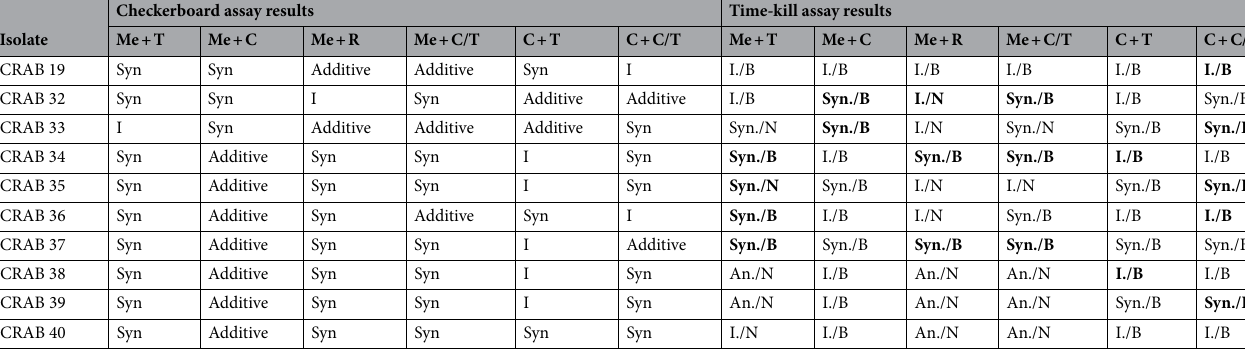
Table 6. Comparison of checkerboard assays and time-kill assays associated with the bactericidal activity of two-drug combinations (1 × MIC) against each Acinetobacter baumannii isolate. An antagonism, B bactericidal, time-kill assay were consistent with the results of the checkerboard assays.